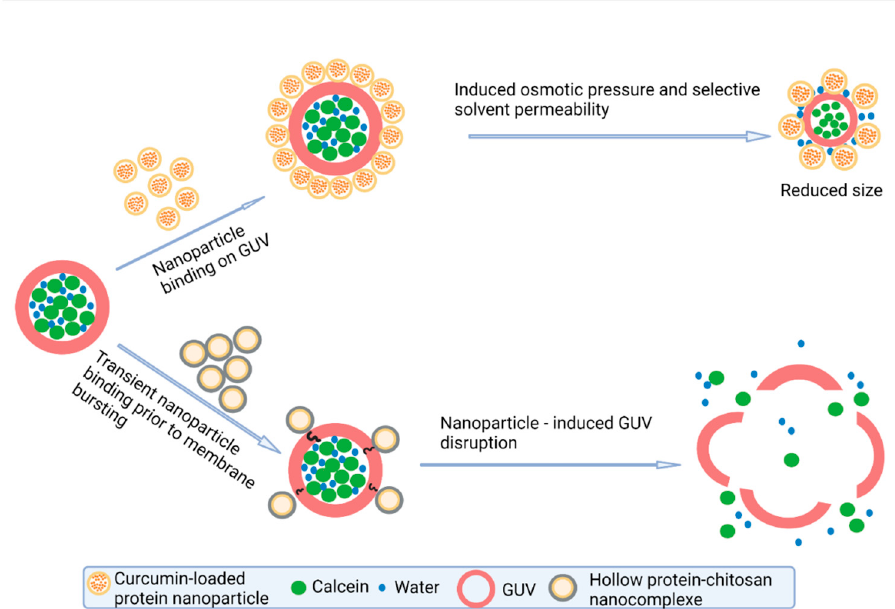
Figure 5. Proposed nanoparticle-giant unilamellar vesicle interaction mechanisms.